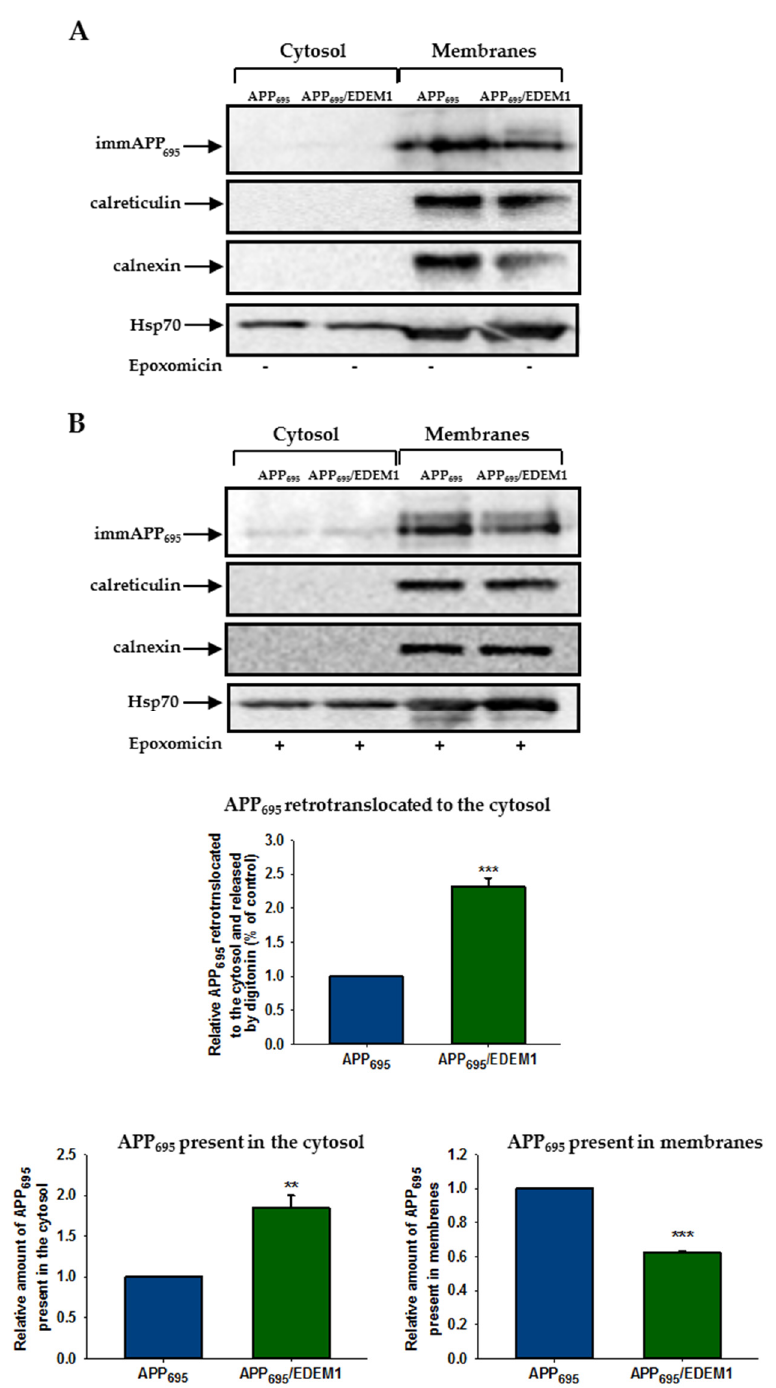
Figure 6. APP 695 retrotranslocation from the ER to the cytosol is dependent on EDEM1. Retrotranslocation assay of APP 695 in APP 695 -transfected cells or cells cotransfected with APP 695 and EDEM1. Immature APP is abbreviated as imAPP. Cells were either ( A ) not treated with epoxomicin, or ( B ) treated with epoxomicin (1 µ g/mL) for 5 h before the permeabilisation procedure was applied. Representative examples of Western blotting of APP 695 , calnexin, calreticulin, and Hsp70 present in the cytosolic and membrane fractions are shown. The graphs show the relative amounts of APP 695 retrotranslocated to the cytosol, present in the cytosol, or present in the membranes in cells treated with epoxomicin. Values obtained for lysates of cells without EDEM1 overexpression are indicated as 1. Values representing EDEM1-transfected cells are plotted relative to 1. The values are expressed as mean ± SD, n = 3, ** p ˂ 0.01,*** p ˂ 0.001, Student’s t test.